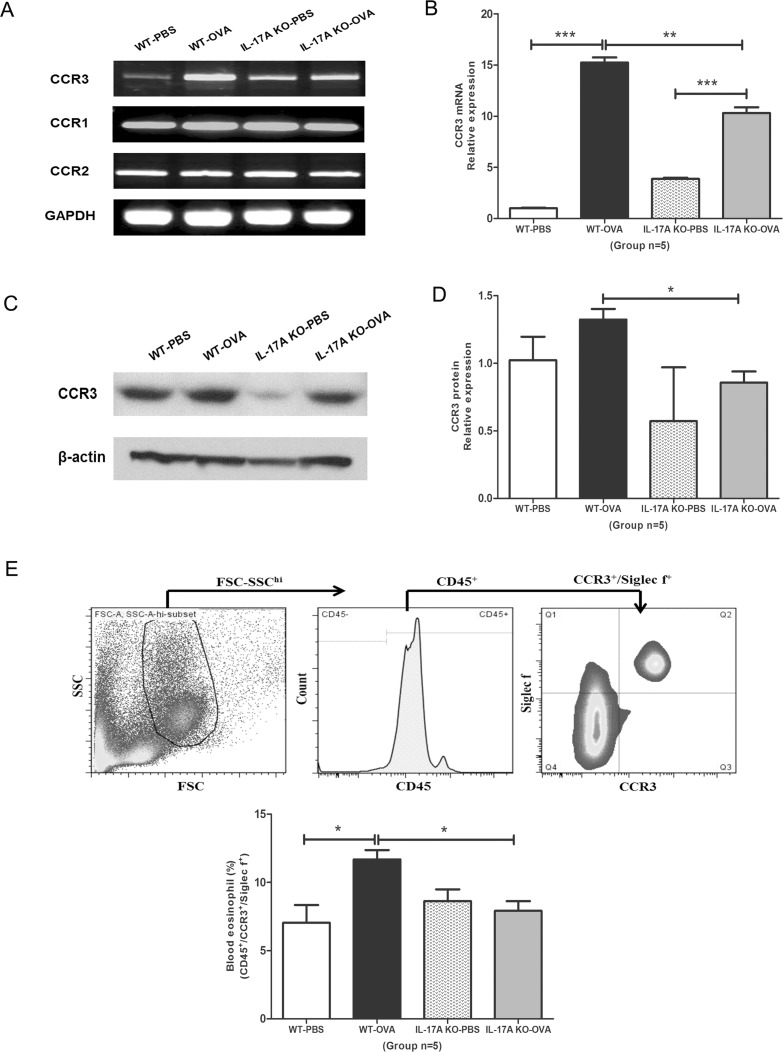
Comparison of CCR3 mRNA and protein levels.(A) mRNA levels of the CCL7 receptors CCR1, CCR2, and CCR3 were measured by RT-PCR. (B) mRNA levels of CCR3 (n = 5) in the nasal mucosa were measured by qPCR. (C, D) The protein levels of CCR3 in the nasal mucosa were measured by (n = 5) Western blot analysis. (E) Flow cytometric analysis of CCR3 expression in eosinophils in blood. Results are means ± SEM (n = 5) (*** P < 0.001, ** P < 0.01, * P < 0.05). Figures are representative results from at least two independent experiments.